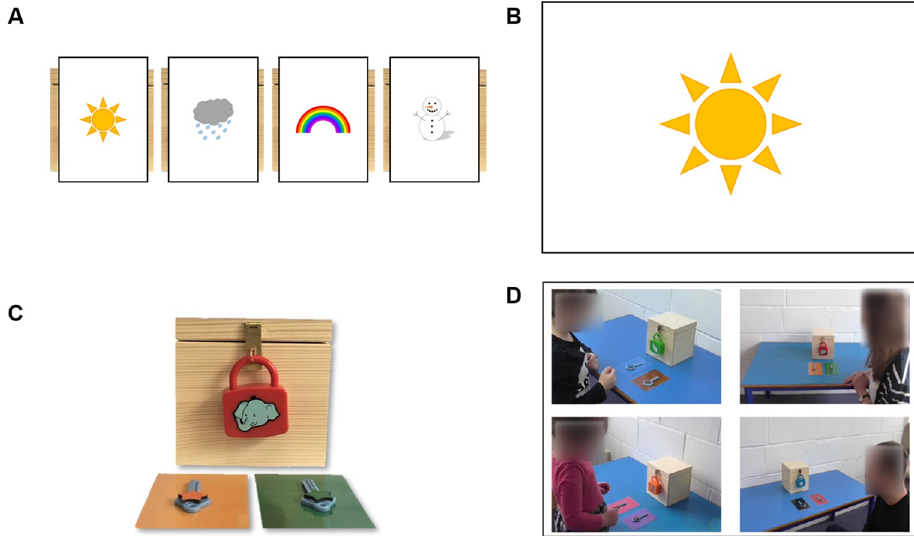
Fig 1. Example of the experimental set-up for one of the four trials. (A) Trial indicator cards placed in front of boxes. (B) Trial indicator image displayed on screen. (C) Box locked with a distinctive padlock, and two possible keys (one correct). (D) Still images presented on the screen representing available demonstration videos (the faces of the demonstrators have been blurred for publication), in this example the target video is on the top right.